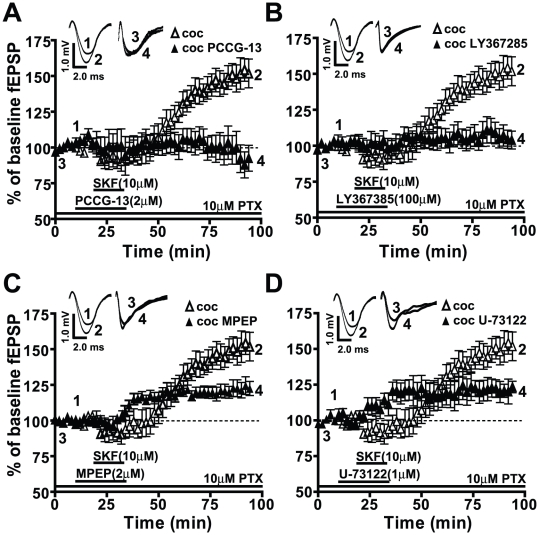
SKF81297-induced LTP in the cocaine CPP group is dependent on the PLD-linked mGluR, mGluR1, and partially dependent on mGluR5 and PLC activity.Responses are plotted as percent change from the baseline fEPSPs as a function of time. Numbers on the representative traces show the time on the graph at which they were recorded. A) SKF81297-induced LTP in the cocaine CPP group (clear triangles, 151.4±8.8%, *p<0.05, n = 6) is completely blocked by the PLD-linked mGluR antagonist (PCCG-13, filled triangles, 95.0±9.2%, n = 6). B) mGluR1 receptor antagonist (LY367385, filled triangles, 106.0±6.7%, n = 6) blocks the SKF81297-induced LTP (clear triangles, *p<0.05, n = 6). C) The mGluR5 antagonist (MPEP, filled triangles, 122.7±5.6%, n = 6) significantly reduces but does not abolish the SKF81297-induced LTP (clear triangles, *p<0.05, n = 6). D) PLC antagonist (U-73122, filled triangles, 128.2±6.1%, n = 6), reduces but does not eliminate the SKF81297-induced LTP (clear triangles, *p<0.05, n = 6). For comparison, panels A and B use same data graphs and fEPSP traces for the slices from cocaine CPP group superfused with SKF81297 as shown in Figures 1, 2 and 3.